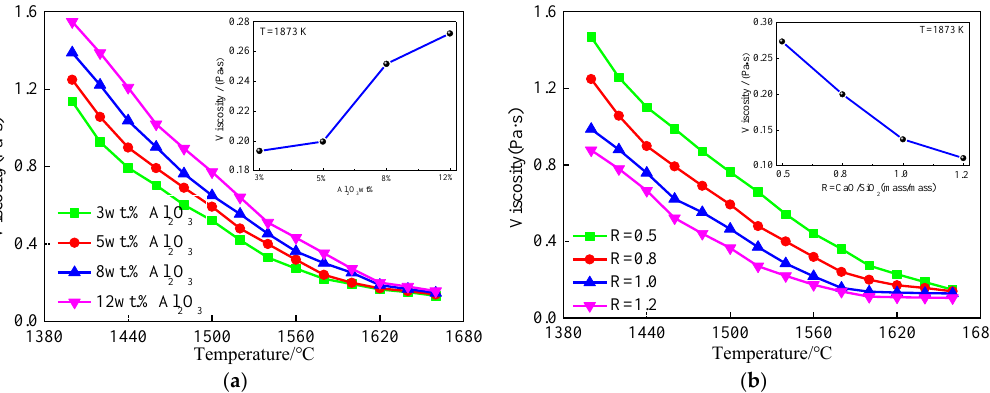
Figure 12. Effect of Al 2 O 3 content and basicity in the CaO–SiO 2 –MgO–Al 2 O 3 slag on the viscosity of the slag at 1873 K. ( a ) Al 2 O 3 content ranging from 3 wt.% to 12 wt.%; ( b ) basicity ranging from 0.5 to 1.2.